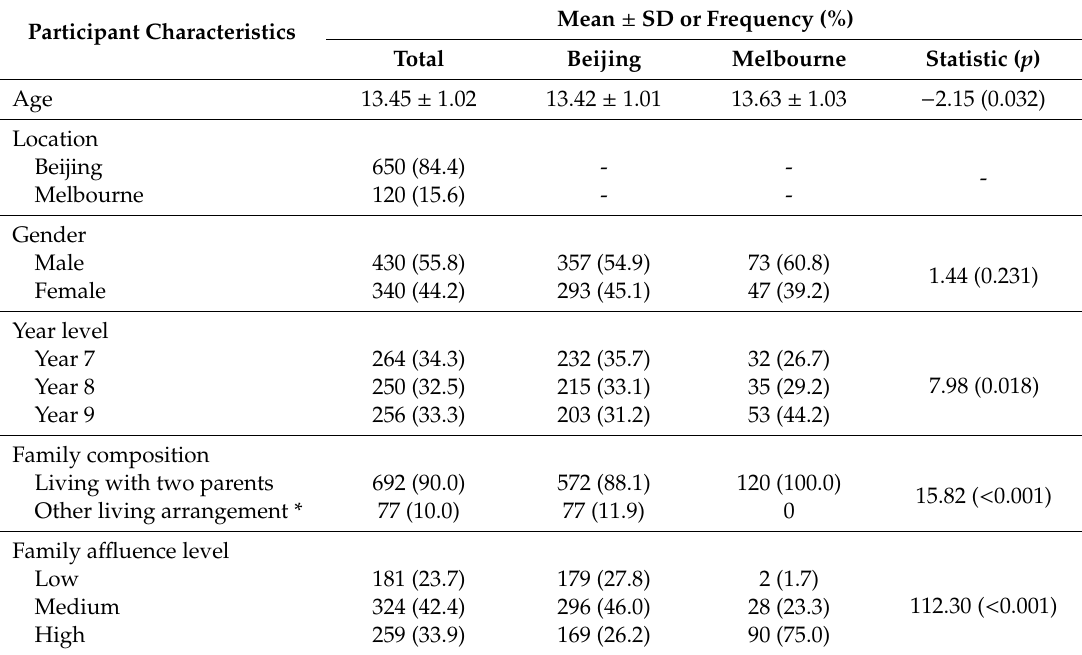
Table 1. Socio-demographics of study